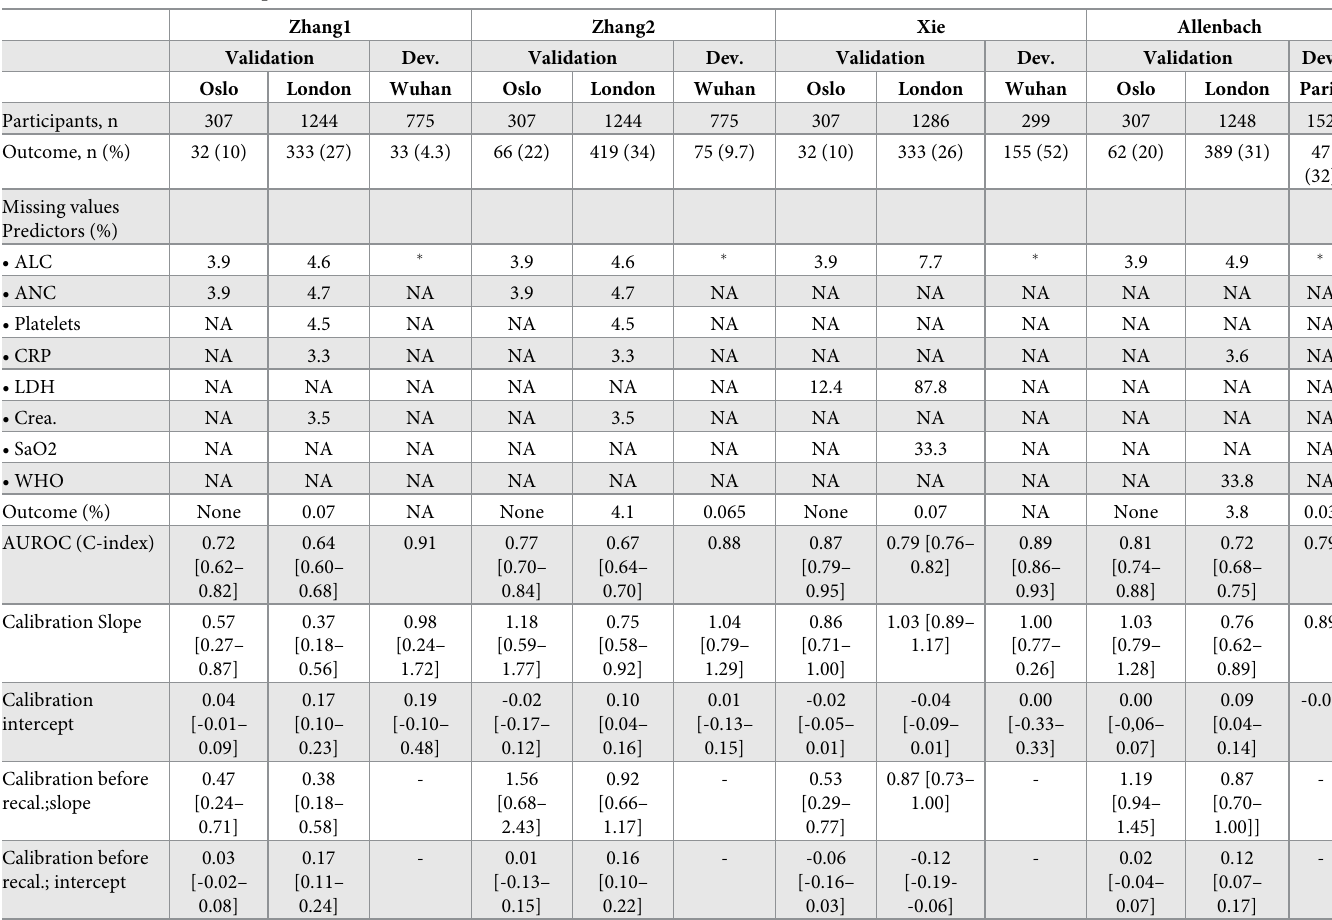
Table 2. Validation of the four prediction